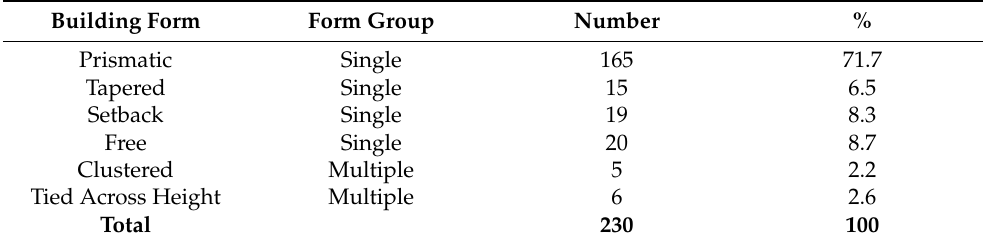
Table 2. Classification of selected tall buildings by building